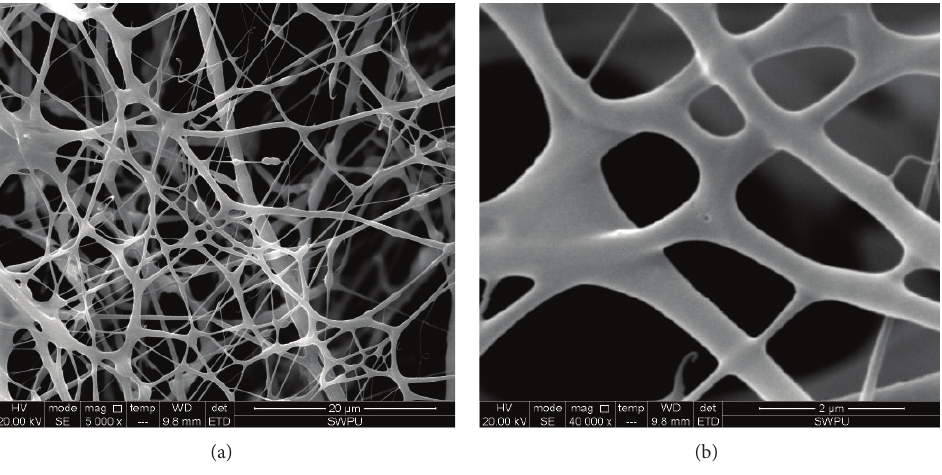
Figure 4: SEM images of